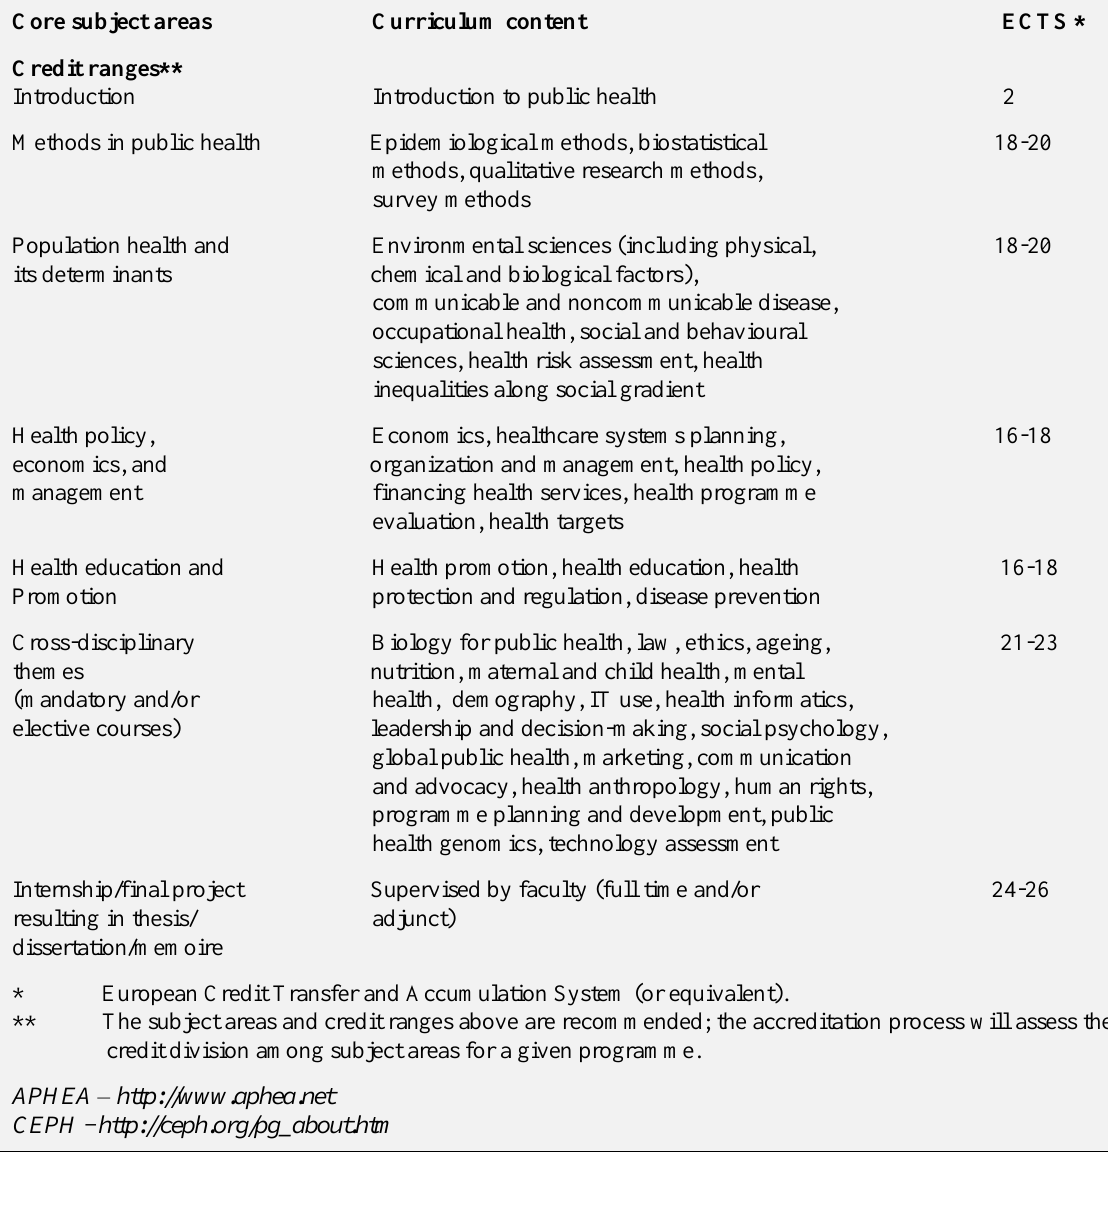
Table 2. APHEA core subject domains for MPH